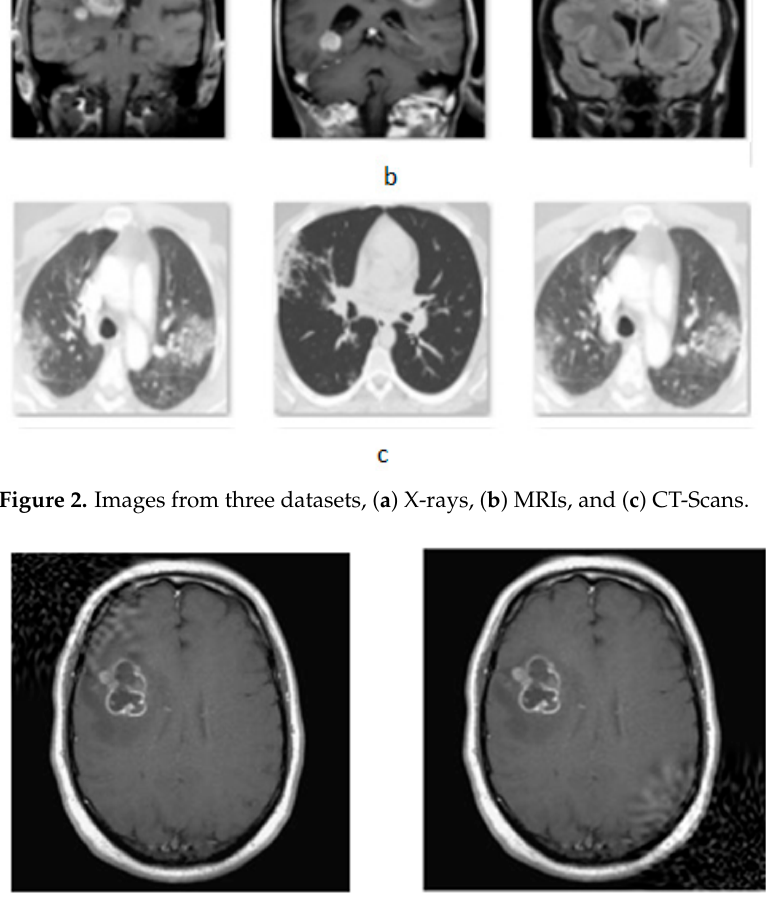
Figure 2. Images from three datasets, ( a ) X ‐ rays, ( b ) MRIs, and ( c ) CT ‐ Scans.